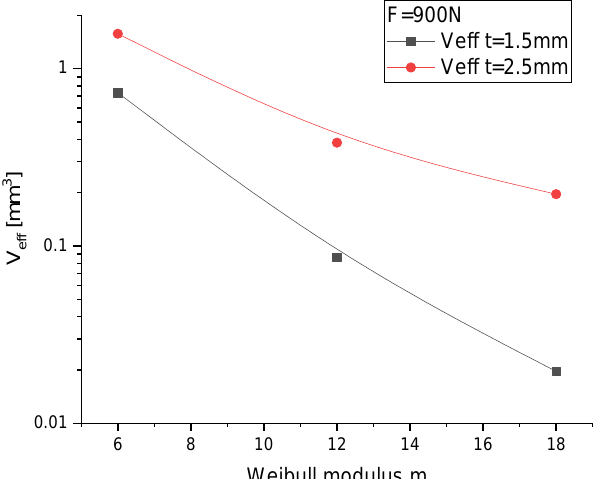
Figure 12. Ball-on-three-balls test: dependence of effective volume on Weibull module and loading parameter F/t 2 .